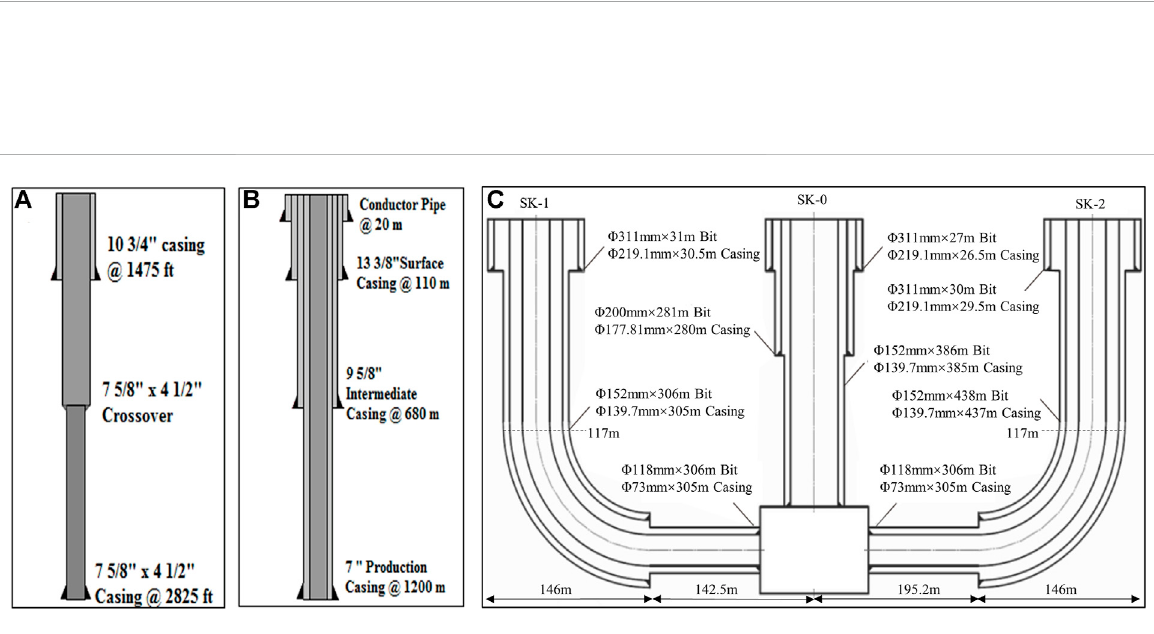
Frontiers in Earth